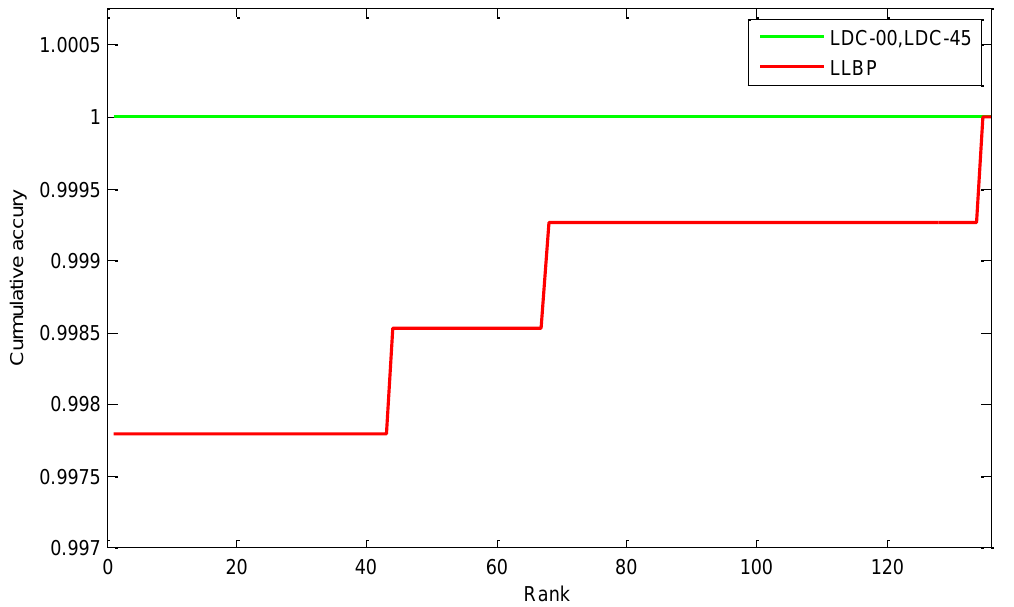
Figure 10. Cumulative match curves by different